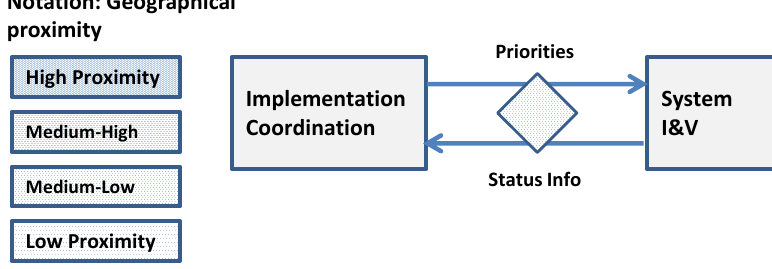
Figure 9. Geographical distances between functional